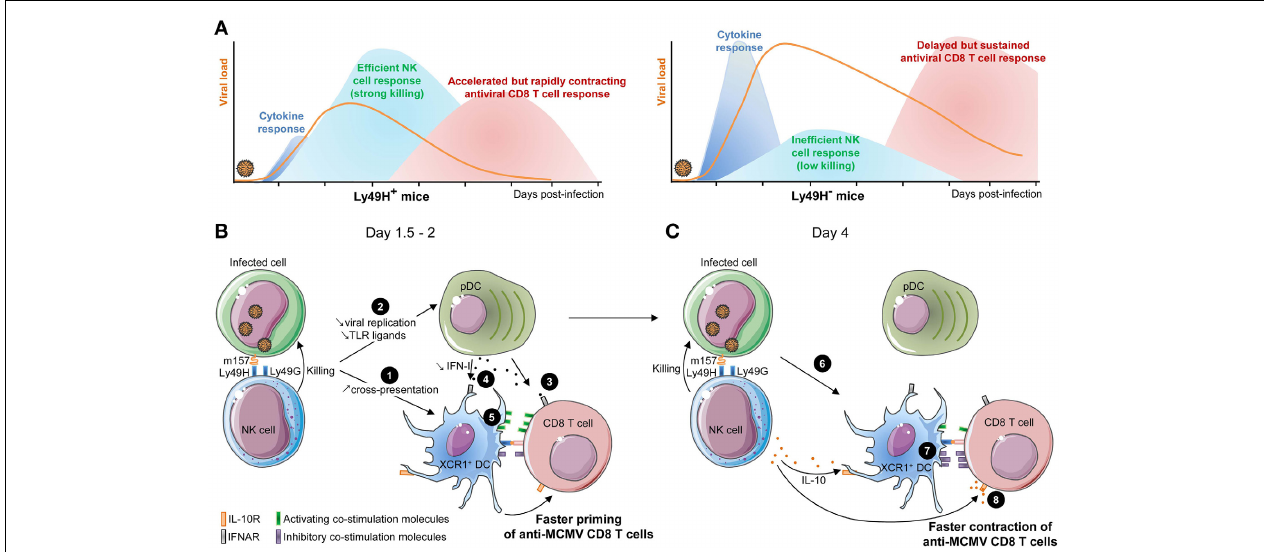
FIGURE 4 | Schematic model of the cross-talk between XCR1 + DC, NK cells, and CD8 T cells during MCMV infection. (A) Comparative kinetics and intensities of innate cytokine, NK and CD8 T cell responses between mice having or lacking an efficient antiviral NK cell response. (B) Potential mechanisms in place early after infection of mice with efficient NK cell responses and promoting accelerated activation of anti-viral CD8 T cells. Early killing of infected cells may provide XCR1 + DC with a faster and increased access to viral antigen for cross-presentation by delivering them immunogenic apoptotic bodies ( ➊ ). It may also reduce the amount of viral ligands accessible to pDC and thus decrease systemic IFN-I production to promote its immune activation effects over the immunosuppressive ones ( ➋ ).